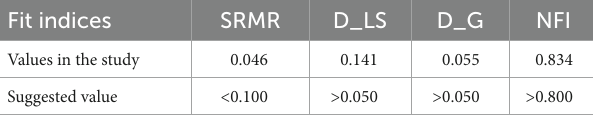
TABLE 5 Assessment of measurement model.